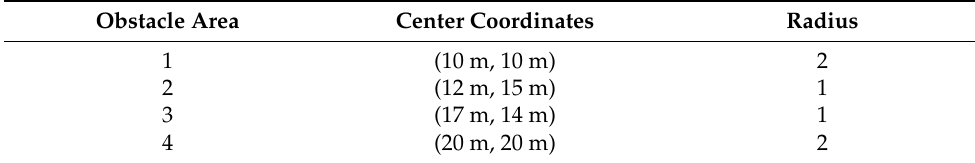
Table 2. Obstacle